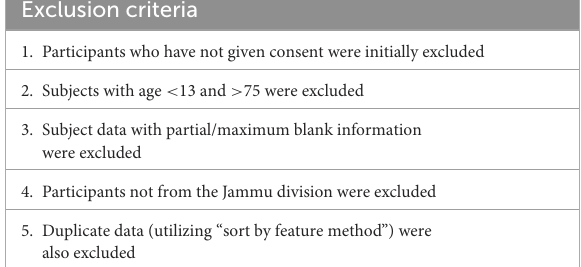
TABLE 2 Exclusion criteria. Exclusion